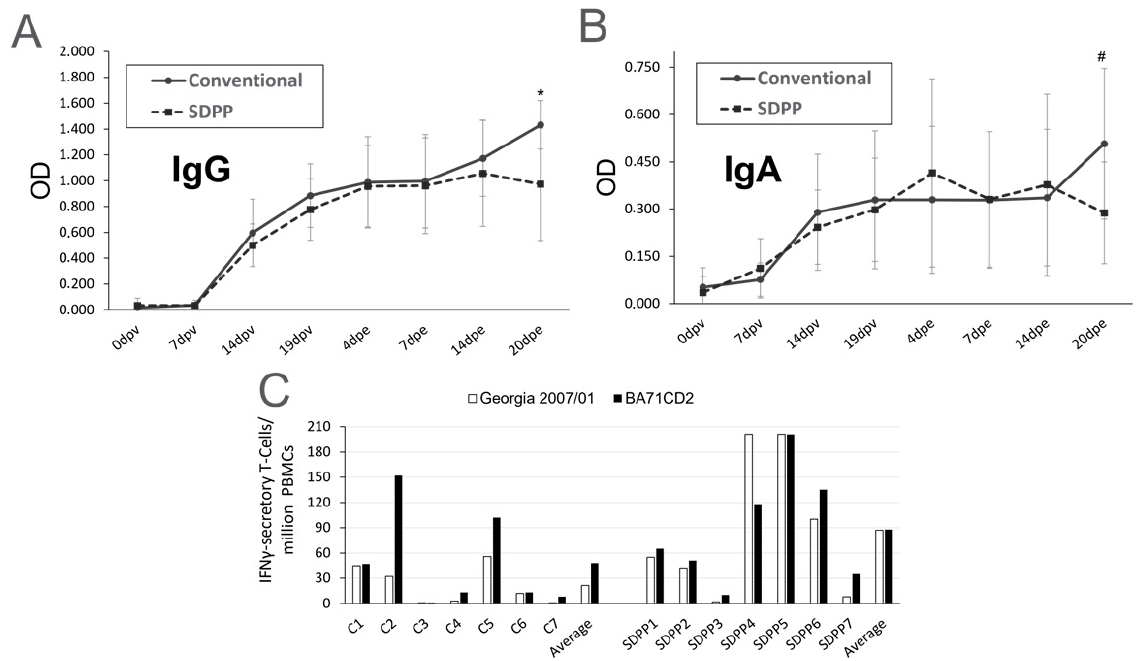
Figure 5. ASFV-specific immune responses analyzed in BA71 ∆ CD2-vaccinated pigs before and after Georgia 2007/01 challenge. ASFV-IgG ( A ) and IgA ( B ) antibodies from sera quantified by ELISA. Average values for SDPP-fed pigs (SDPP1-7) are shown as dashed lines, while solid lines represent average values for pigs fed the conventional diet (C1–C7). Standard deviation values are shown. ( C ) Number of ASFV-speci fi c IFN γ -secreting T cells found at d9pe by ELISPOT in PBMCs upon in vitro stimulation with either the pandemic Georgia 2007/01 (white boxes) or the BA71 ∆ CD2 vaccine (black boxes). * = p < 0.05; # = p < 0.1.